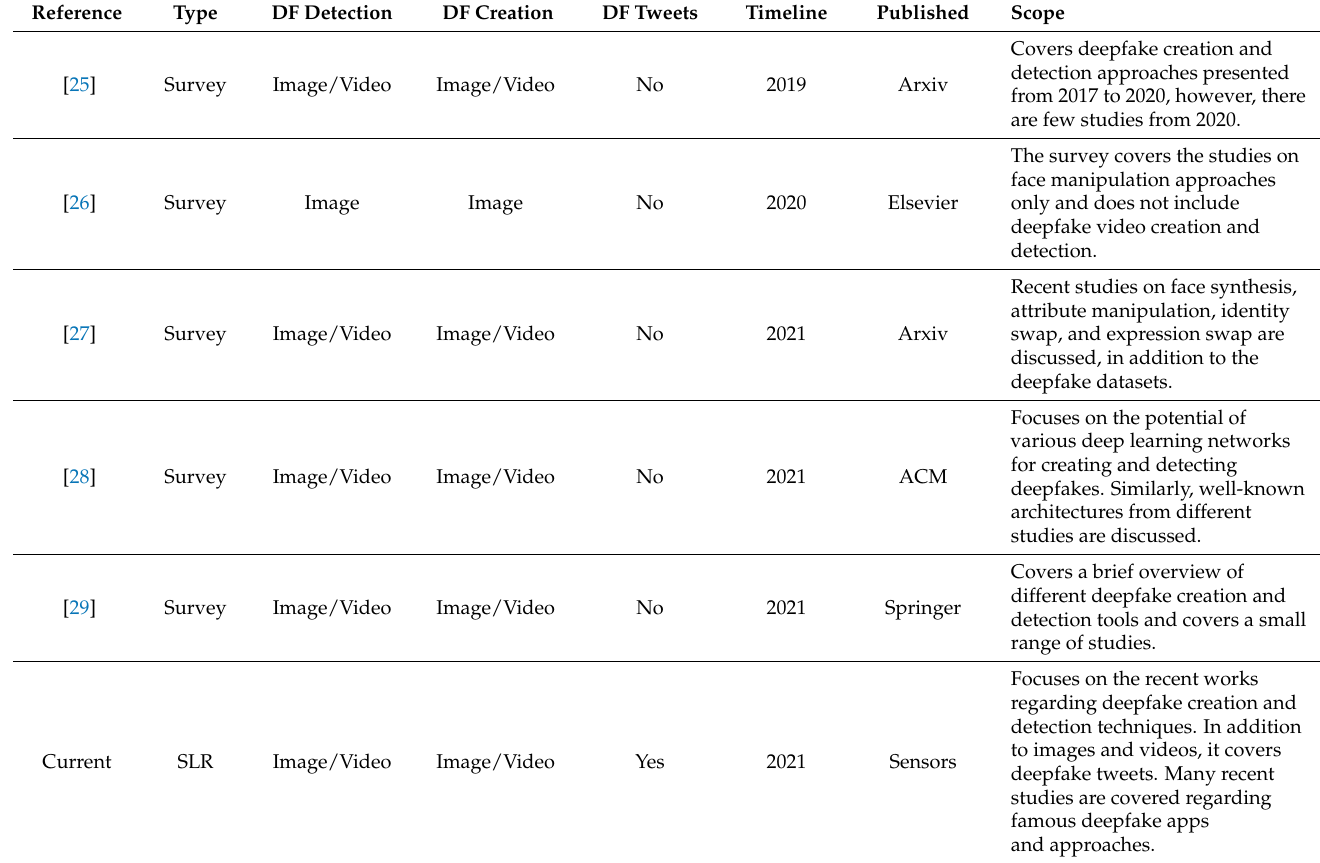
Table 1. A comparative analysis of review/survey papers on